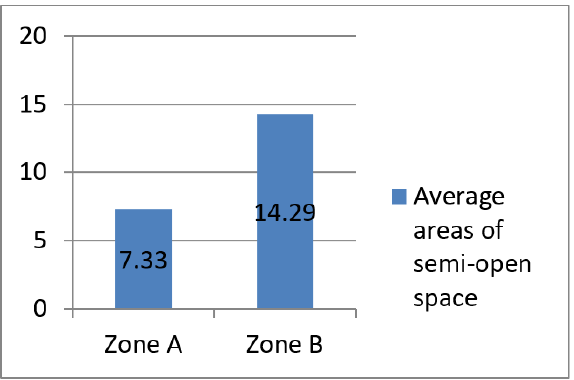
Figure 32. Average areas of front doors in Zone A and Zone B.